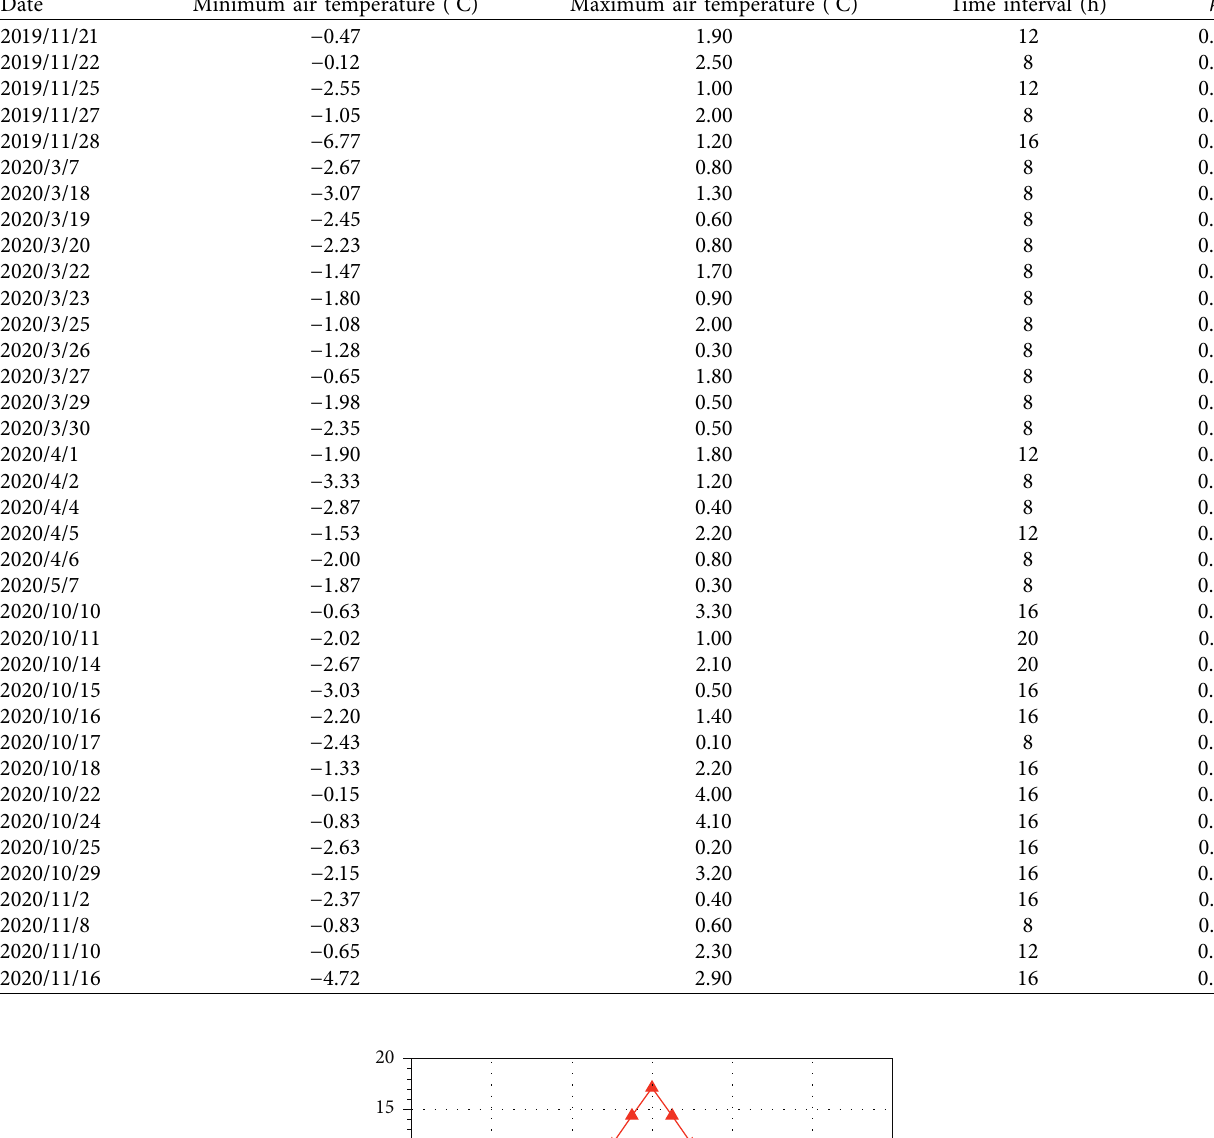
Table 2: The calculation value of κ i at D1 section of the tunnel using equation (21).